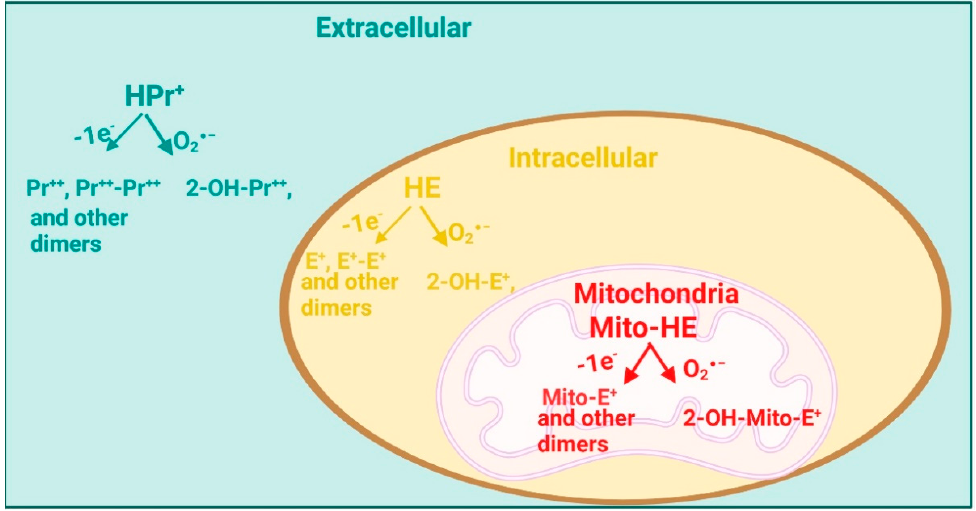
Figure 9. Detection of the site-specific formation of the O 2· − and other oxidants using the DHE and its site-specific analogs. 2-OH-E + , 2-hydroxy-ethidium; 2-OH-Mito-E + , 2-hydroxy-mito-ethidium, 2-OH-Pr ++ , 2-hydroxy-propidium; E + , ethidium; E + -E + , ethidium dimer; HE, dihydroethidium; HPr + , hydropropidine; Mito-HE, mitoSox, triphenylphosphonium-linked hydroethidium; Pr ++ , propidium; Pr ++ -Pr ++ , propidium dimer. Redrawn and modified from reference [173] with permission (License Number 5484770645928). © 2016 Elsevier Inc.